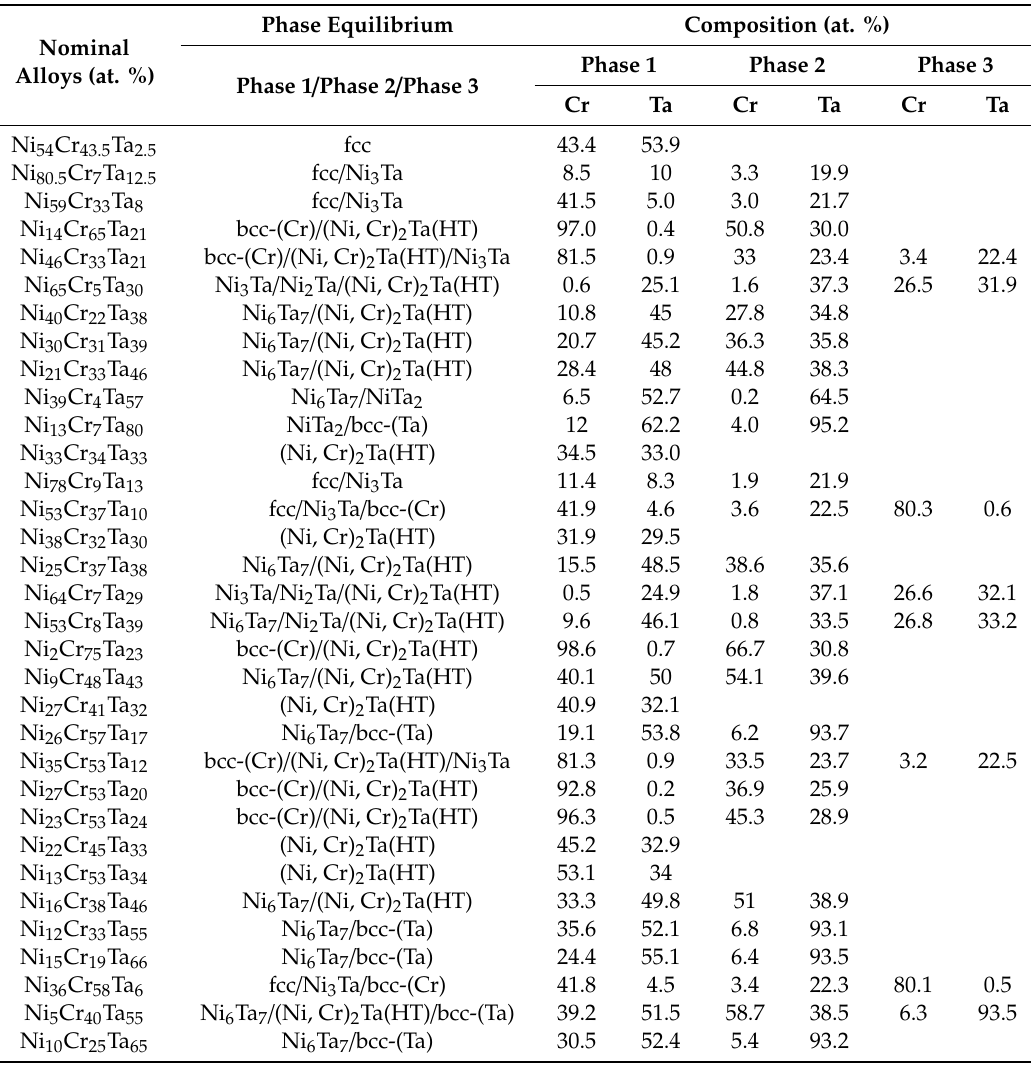
Table 2. Equilibrium compositions of each phase in the Ni-Cr-Ta ternary alloys annealed at 1200 ◦ C for 35 days.